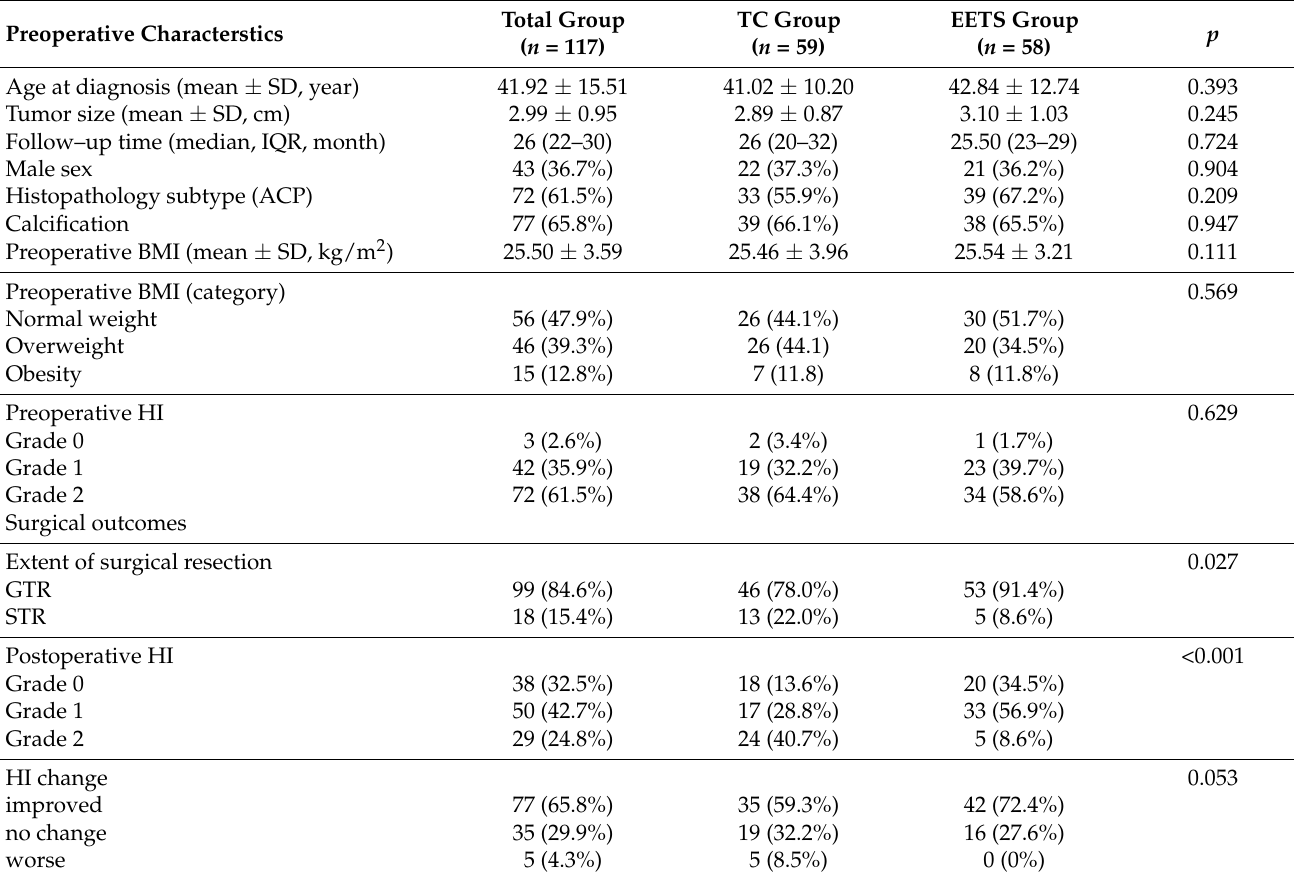
Table 1. Preoperative characteristics and surgical outcomes of 117 patients with adult-onset cran- iopharyngioma. SD, standard deviation; IQR, interquartile range; ACP, adamantinomatous cranio- pharyngioma; BMI, body mass index; HI, hypothalamic involvement; TC, traditional